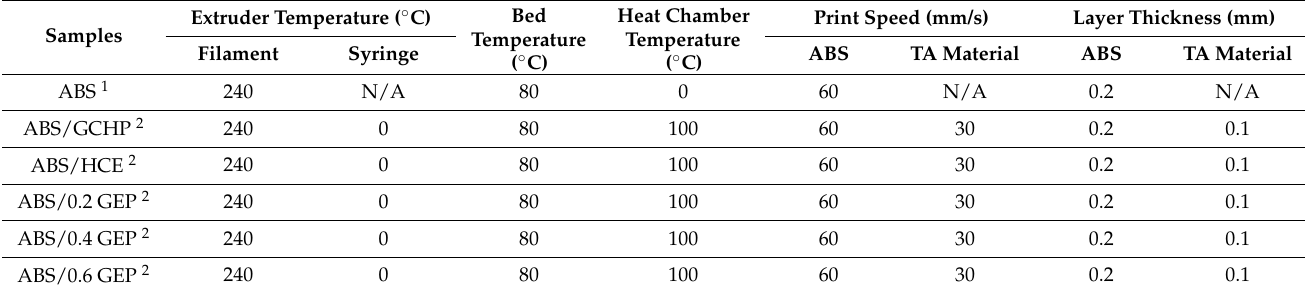
Table 1. Process parameters for ABS and ABS-based plastic